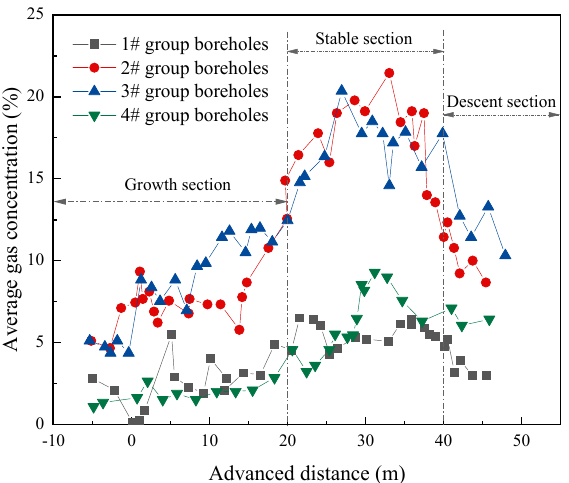
Figure 9. Gas concentration variation in boreholes with the advancement of the working face. Gas concentration in the 1# group of boreholes with a maximum vertical distance of 8.5 m is the lowest, presenting an average gas concentration of 4.01% during mining. Although the borehole end is located in the ultra-high permeability area, a large quantity of air is extracted into the borehole under negative pressure due to its connection with the goaf. Meanwhile, the borehole in the caved zone collapses with the advancement of the working face, substantially weakening its gas extraction performance. Gas concentration in the caved zone decreases to an unacceptable